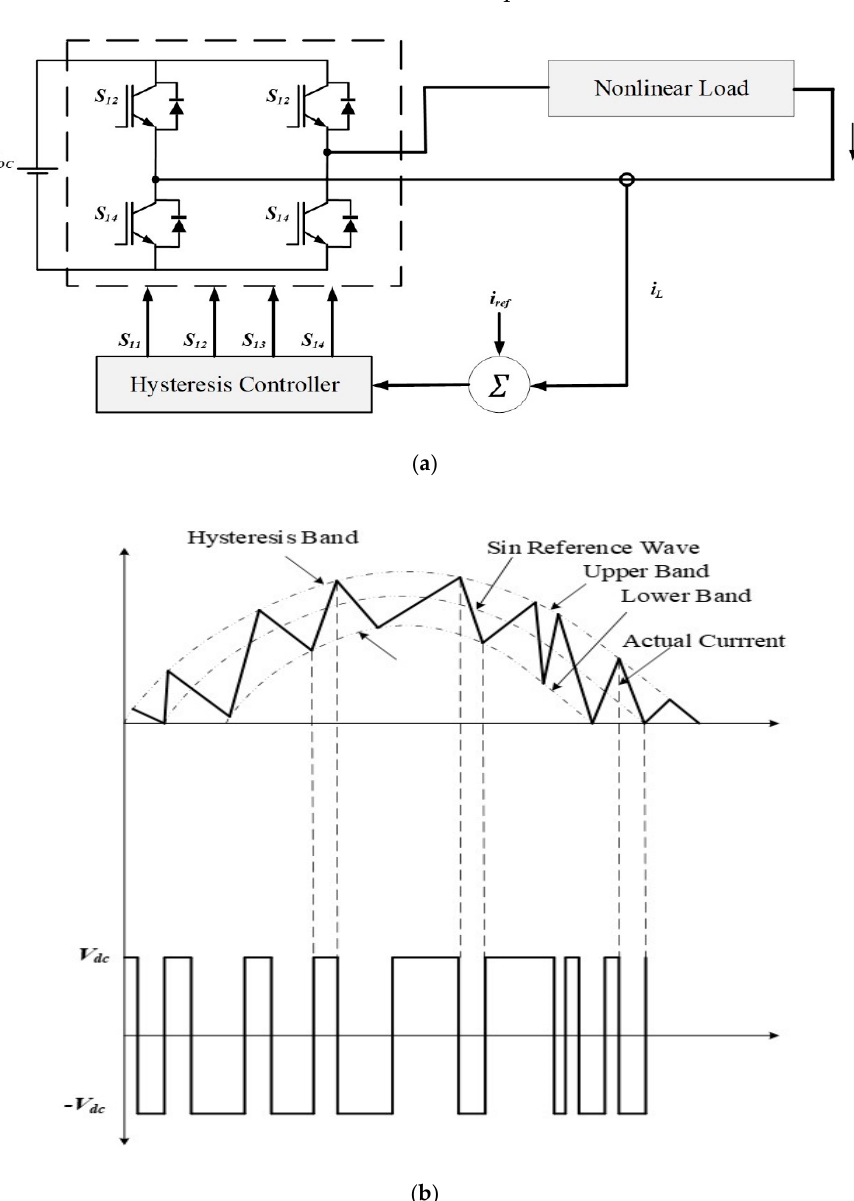
Figure 21. Hysteresis current control: ( a ) schematic diagram of a H-bridge cell with hysteresis regulator; hysteresis current control ( b ) hysteresis current band and voltage curves of load feedback.